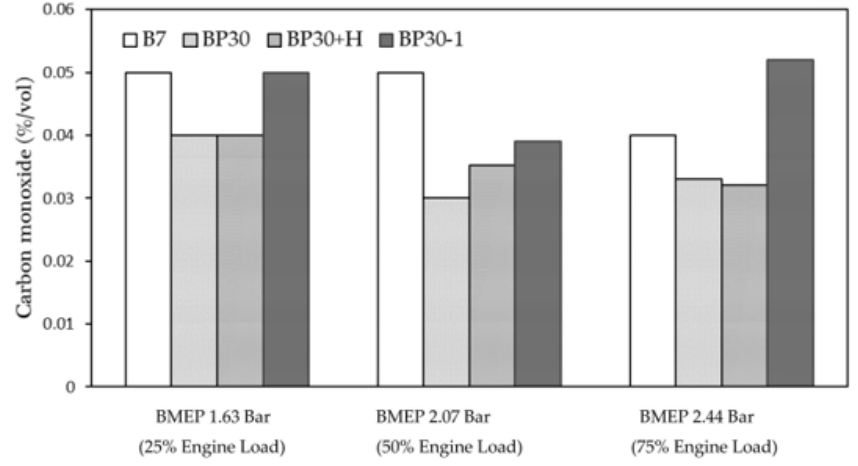
Figure 14. Effects of fuel enhancement on carbon